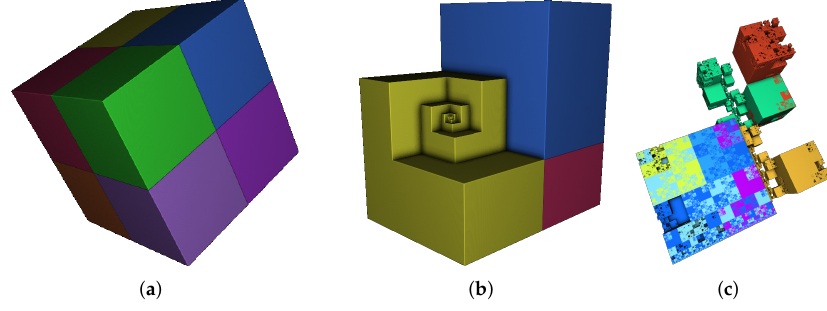
Figure 12. Polyhedral rep tiles for m = 8. ( a ) Cube, ( b ) Chair tile, ( c ) A cube tile.